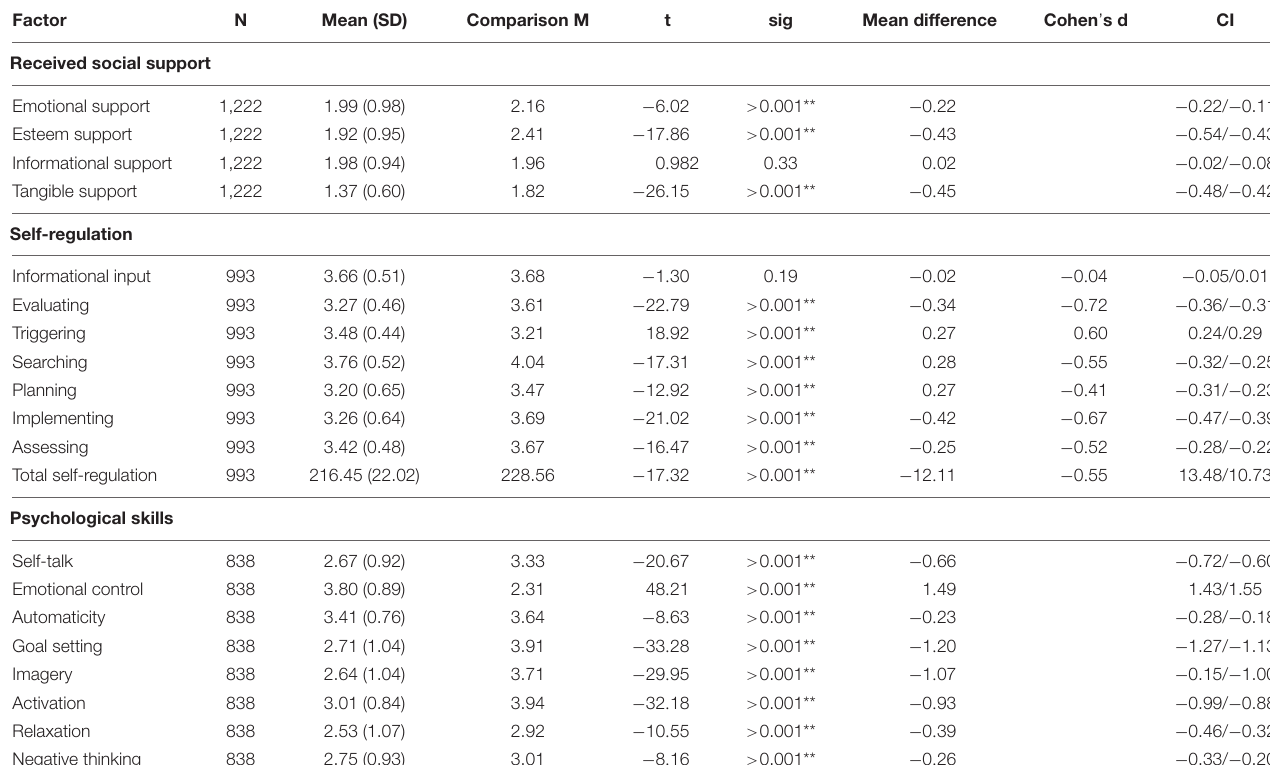
TABLE 5 | T -test comparisons between traditional sports and esports data (** P <